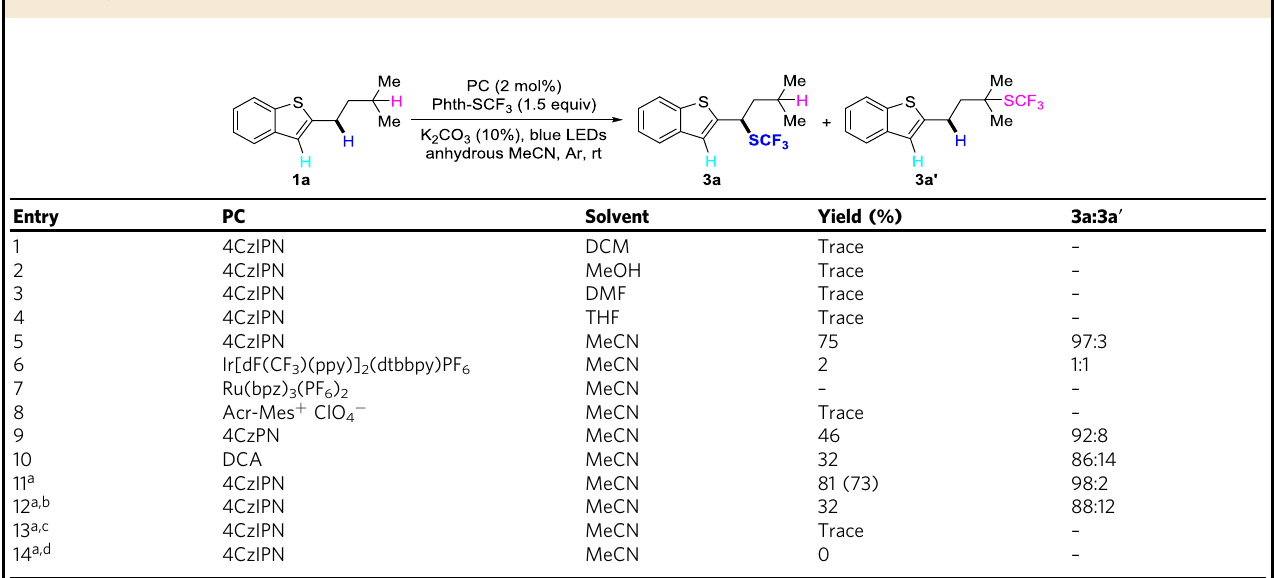
Table 1 Optimization of reaction